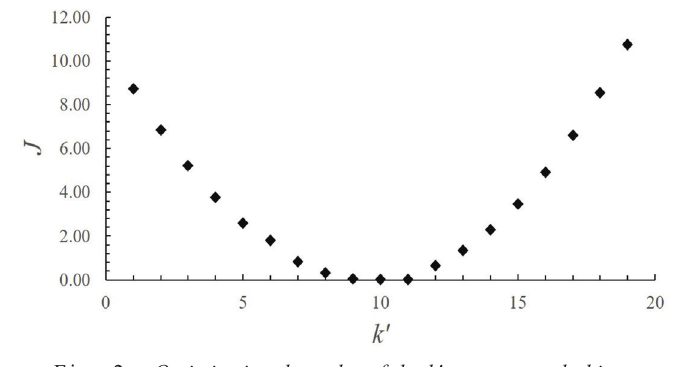
Fig. 2 – Optimization data plot of the k' constant and objec- tive function J